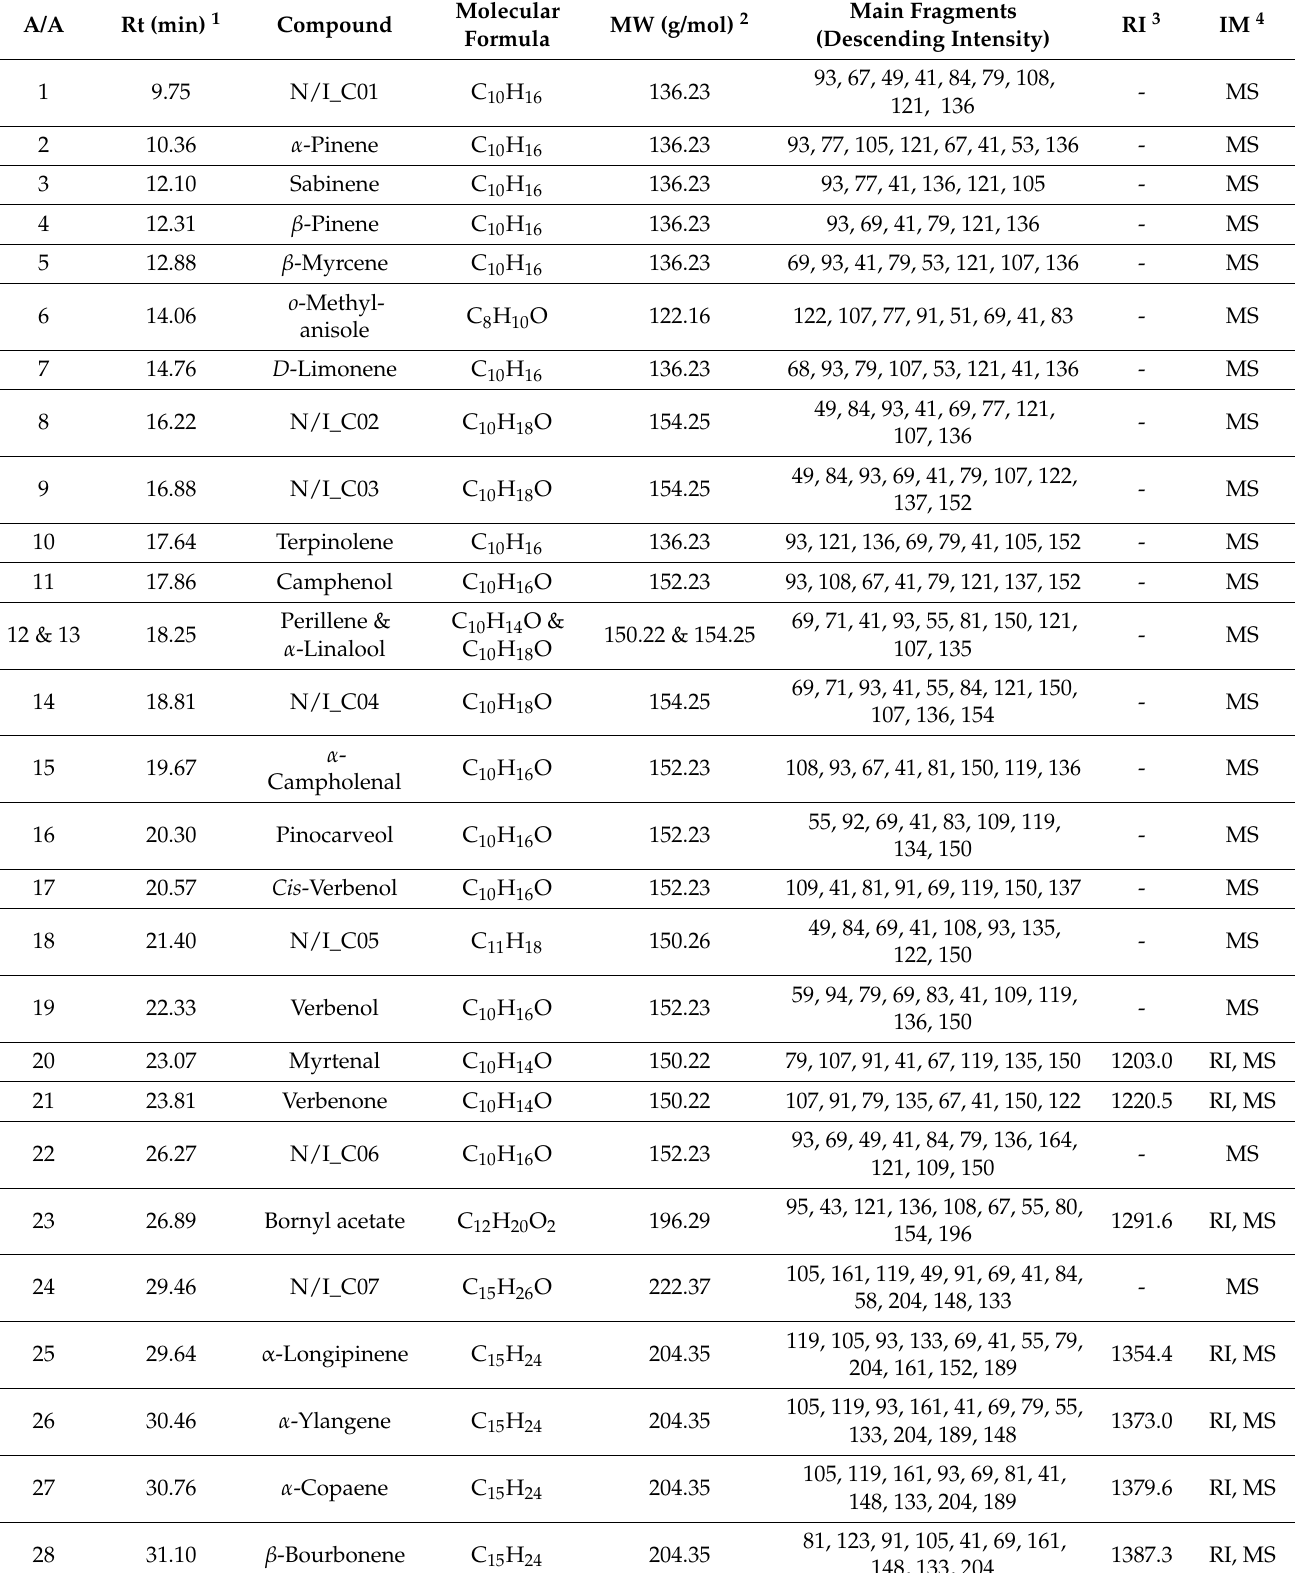
Table 2. GC-MS analysis of the essential oil composition of fresh CMO samples (CMO_1–7)